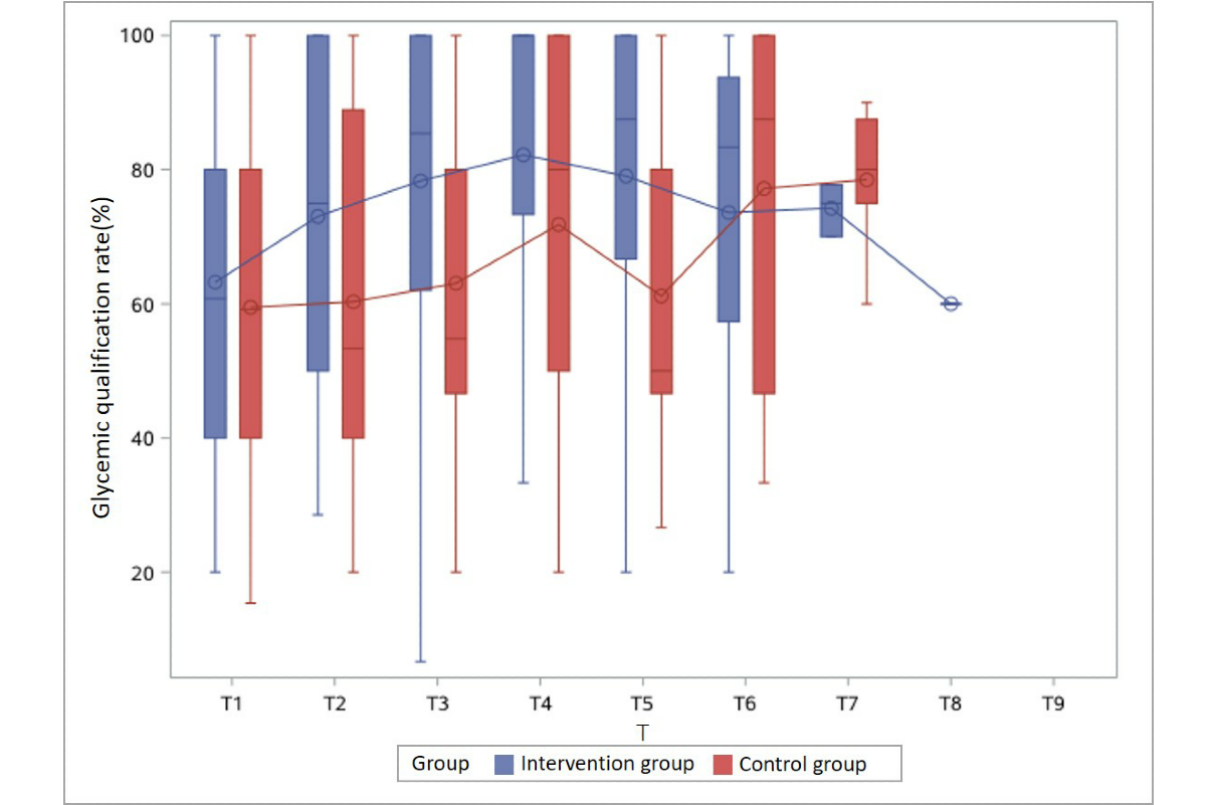
Figure 2. Glycemic qualification rate of the intervention and control groups in Group 1 (enrolled between 23 and 24 [+6] gestational weeks) at different time points. T: 2-week period.